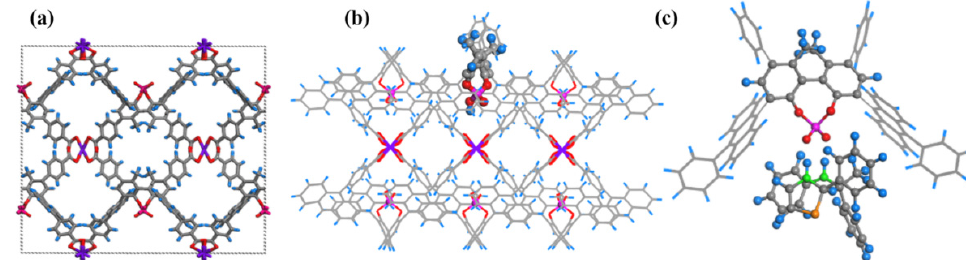
Figure 6. ( a ) In-MOF ( b ) two-layer ONIOM model ( c ) TS near the CPA. Color code: In, dark purple; P, pink; O, red; N, green; C, grey; S, orange and H, blue. In ( b , c ), the inner and outer layer are represented by the ball-stick and line, respectively.